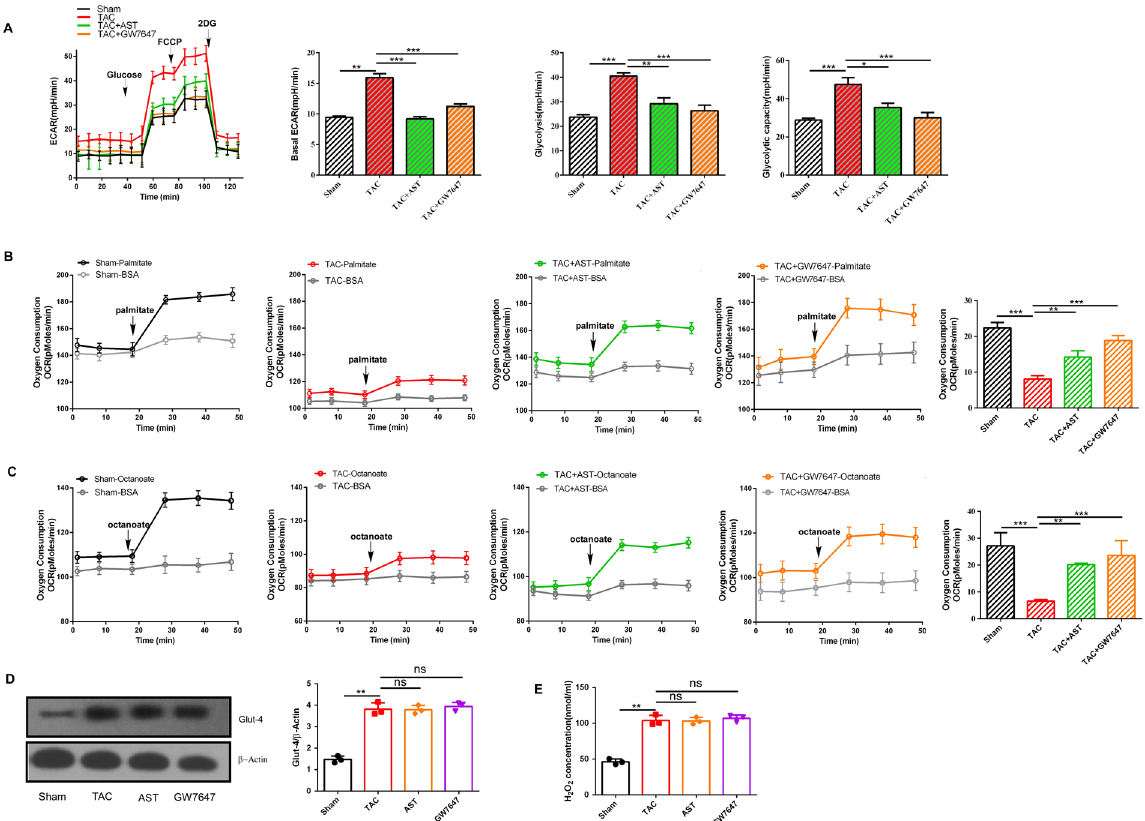
Figure 4. Astragaloside IV treatment inhibited glycolysis and accelerated fatty acid β -oxidation in isolated hypertrophic myocardial cells. ( A ) Extracellular acidification rate measurement trace during the Seahorse glycolysis stress assay, in which the medium bathing the isolated myocardial cells was sequentially injected with 20 mM glucose, 1 μ M oligomycin and 2-deoxy glucose (20 mM). Glycolysis rates were calculated by subtracting the normalised extracellular acidification rate values after injection of 2-deoxy glucose (20 mM). ( B ) The kinetic oxygen consumption rate (OCR) response in isolated myocardial cells to the long-chain fatty acid palmitate (150 μ M). ( C ) The kinetic OCR response in isolated myocardial cells to the medium-chain fatty acid octanoate (1 mM). Isolated myocardial cells were seeded onto a 24-well XF plate. After incubation for 3 h, the culture media was replaced with XF base medium. Fatty acid oxidation was expressed as OCR. * P < 0.05, ** P < 0.01 and *** P < 0.0001 (n = 5). Data are mean ± s.d. ( D ) Western blotting analysis of Glut-4 expression. The original gels images used for A are shown in Supplementary Fig. S5. ( E ) The activity of glucose oxidase was detected by glucose oxidase activity assay kit. * P < 0.05, ** P < 0.01 and *** P < 0.0001 (n =